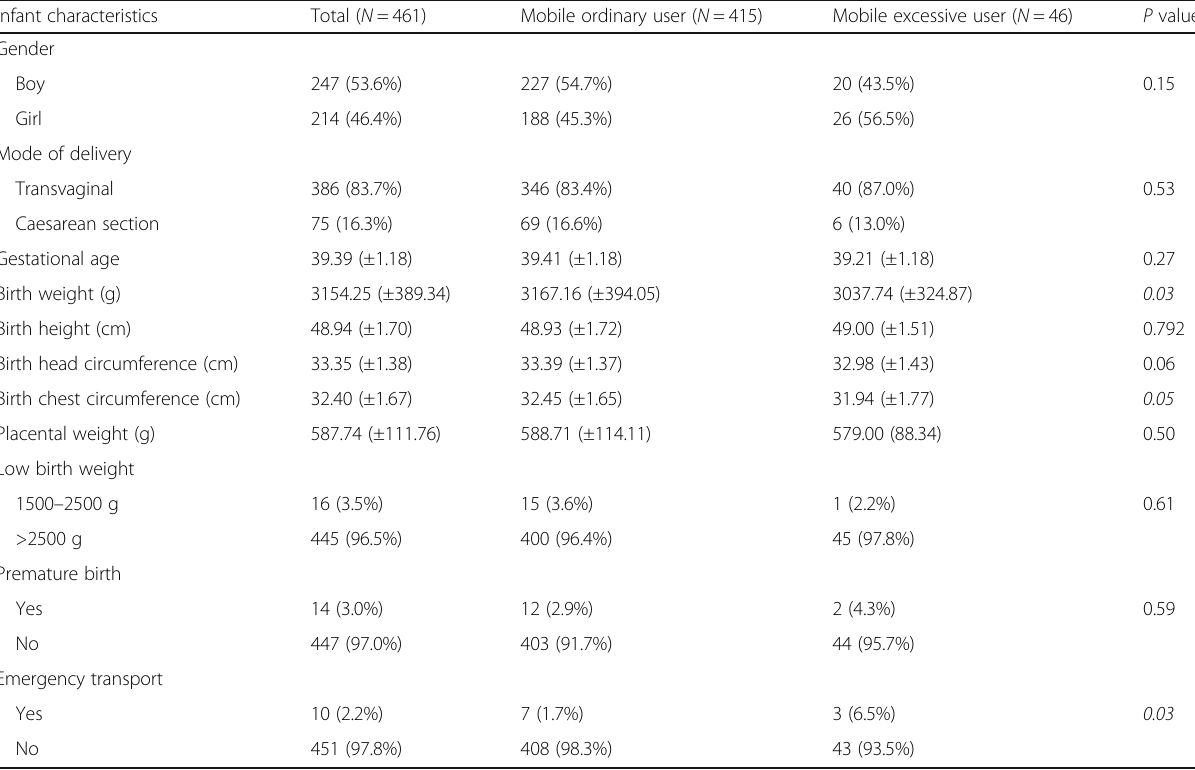
Table 2 Infant characteristics and their differences between the normal and excessive use